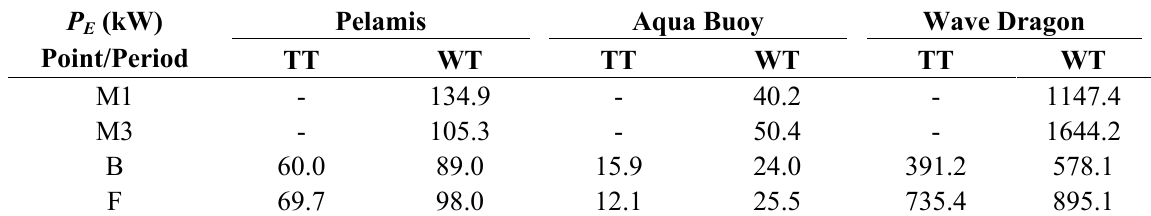
Table 8. Average electric power in kW for the converters: Pelamis, Aqua Buoy and Wave Dragon in two reference points in Madeira (M1 and M3), one reference point in the Black Sea (B-point) and other reference point in the North Sea at Fino station